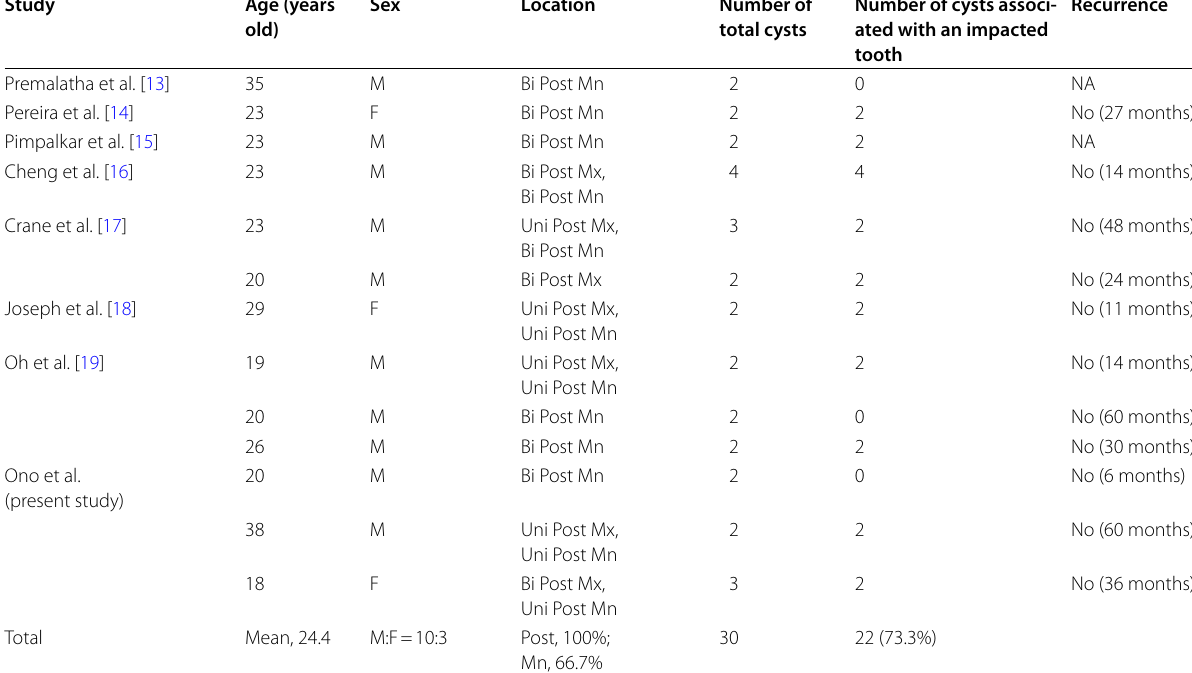
Table 1 Clinical findings of multiple orthokeratinized odontogenic cysts in previous reported cases and present series Study